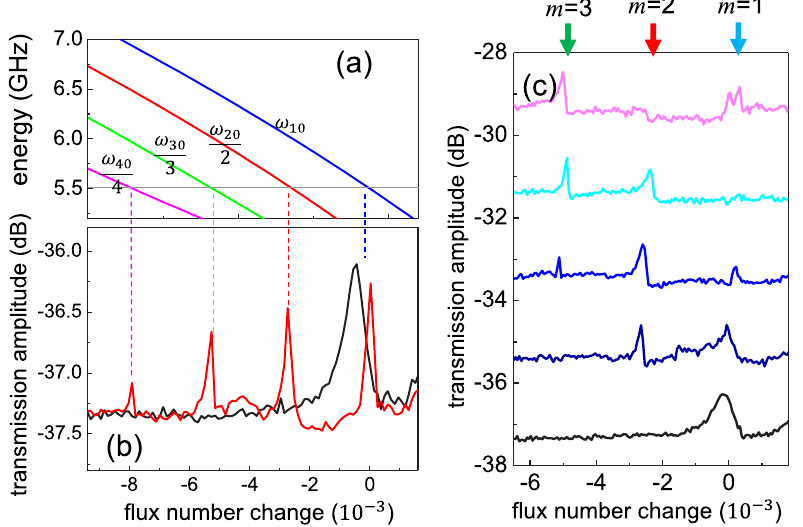
Figure 3. ( a ) The calculated transition energies ω m 0 / m as a function of bias flux number in our atom. The 5.5145 GHz. ( b ) The transmission amplitude as a function of bias flux grey horizontal line marks ω p = 125 dBm, only 0 1 number(change) for different probe powers at 5.5145 GHz. At a lower power P p to = − | � | � 110 dBm, 0 m transition was observed(black). At a higher power P p to transitions with m 1, 2, 3 and 4 = − = | � | � were observed (red). The peak positions agree well with the crossing points in ( a ). ( c ) The transmission of the 5.513 GHz as a function of flux number change at various driving microwave probe microwaves at ω p / 2 π = 5.455 GHz. The curves are vertically shifted for clarity. From the bottom to top, the driving powers at ω d / 2 π = 108, 104.5, 102 and − 100 dBm. In the absence of driving microwaves, the transmission power: off, P d = − − − ω p . For higher driving powers, the shows a single resonance peak corresponding to transition energy ω 10 = 3 and 3 , corresponding to m 2.6 10 5.3 10 2 , and 3 in ( b ), resonance peaks appear at flux number − − = − × − × = respectively.